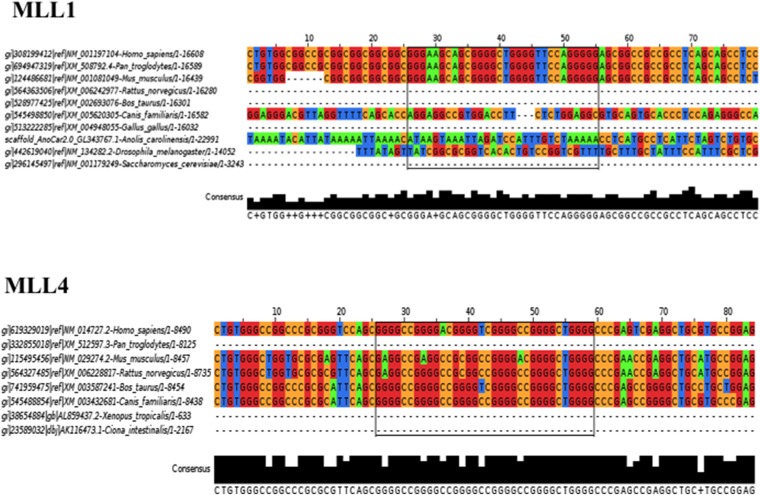
Sequence conservation of the MLL1 and MLL4 PG4 sequences.